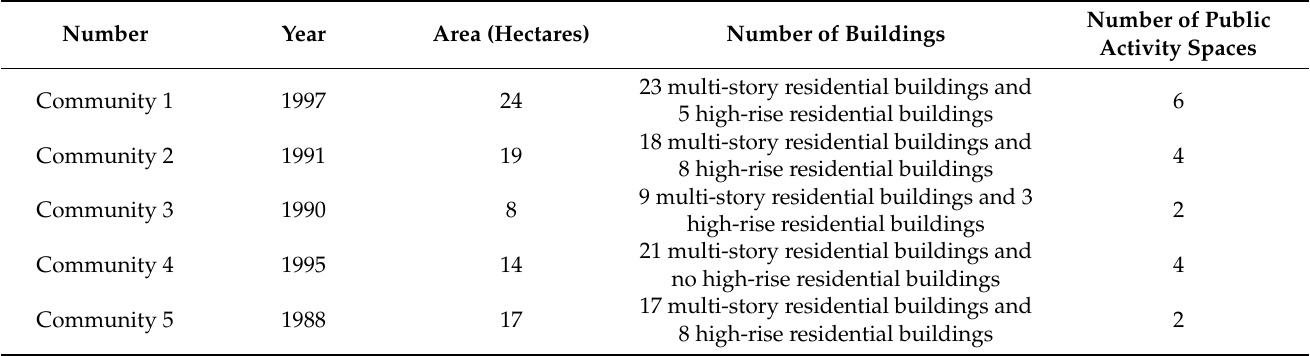
Table 1. The information of five surveyed communities.